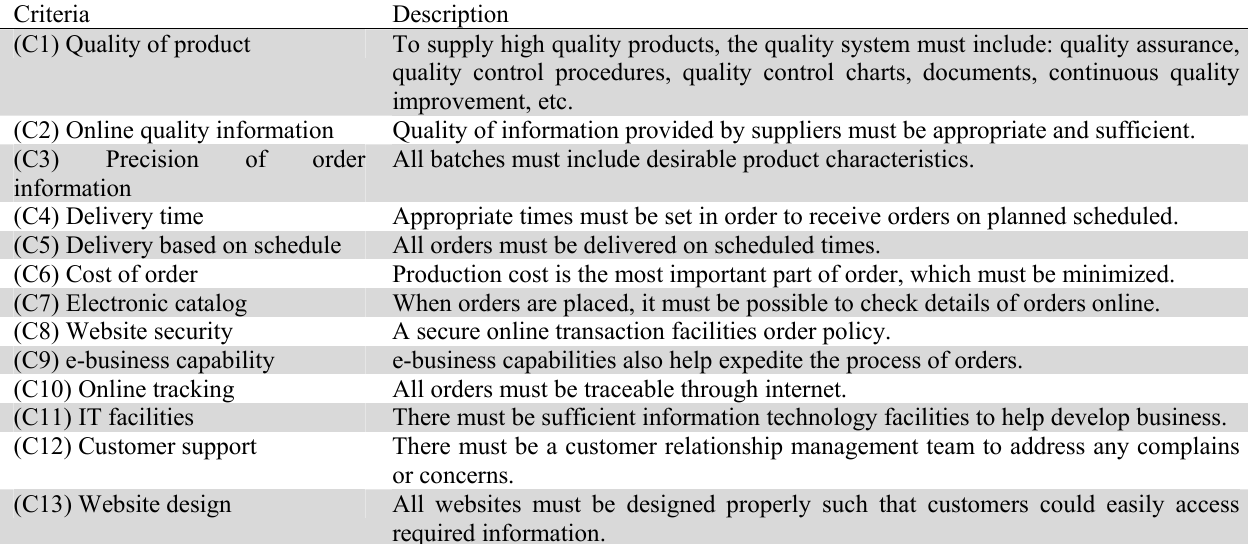
Description of the criteria associated with electronic green supply chain Criteria